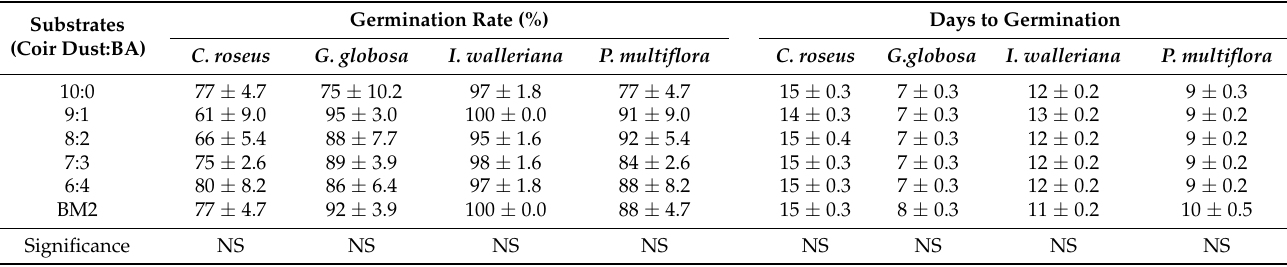
Table 3. The final germination percentages and days to germination of four bedding plants ( Catharanthus roseus , Gomphrena globosa , Impatiens walleriana , and Petunia multiflora ) sown in mixed coir dust and coal bottom ash (BA) substrates and in a commercial germinating mixture